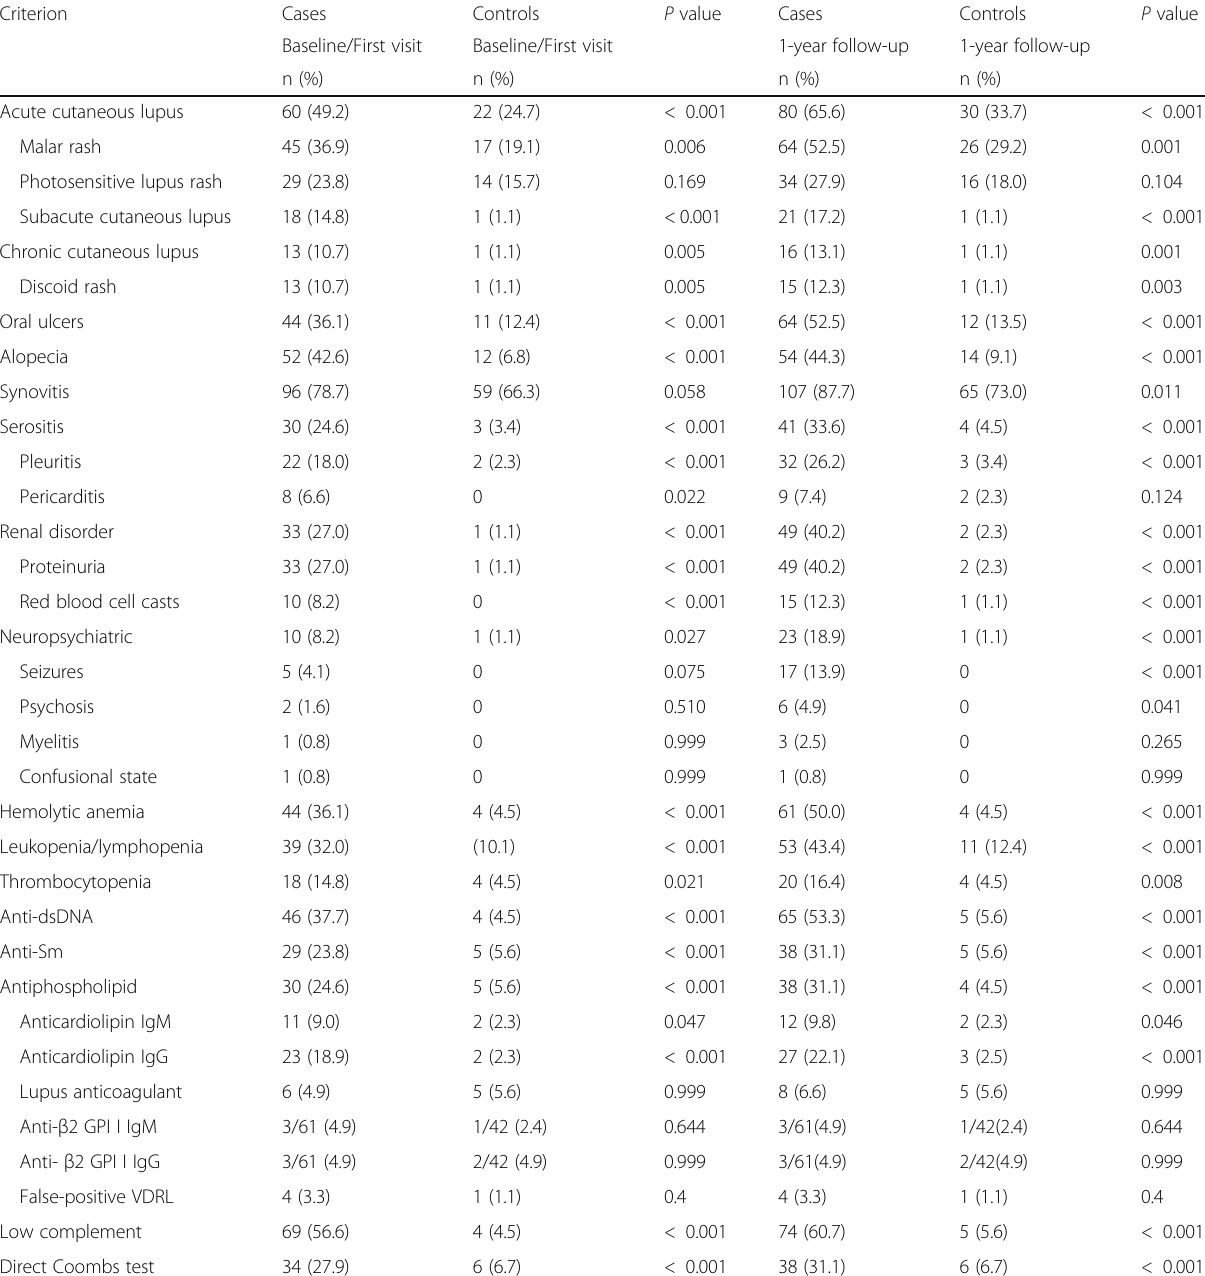
Table 2 Prevalence of clinical and immunological criterion of Systemic Lupus International Collaborating Clinics (SLICC) Classification Criteria in 122 cSLE cases and 89 controls, at baseline/first visit and 1-year-follow-up